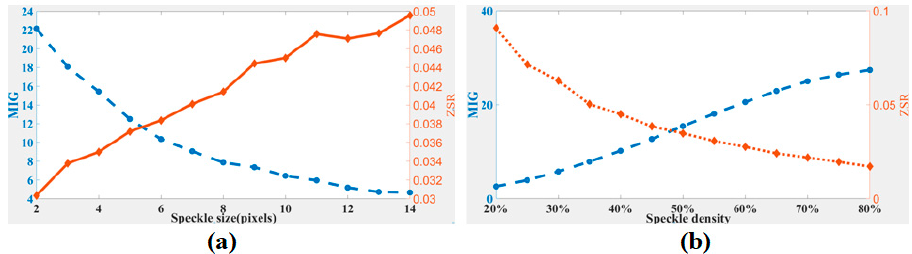
Figure 3. Assessment results of speckle patterns with ( a ) different speckle sizes and ( b ) different speckle densities.